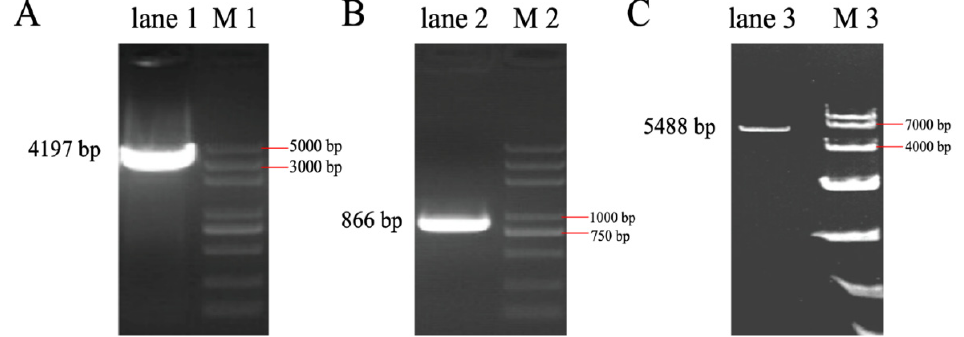
Figure 3. The full-length sequence of LincRNA-ROFM was obtained by RACE technology. ( A ) The result of 5 ′ -RACE in lane 1. ( B ) The result of 3 ′ -RACE in lane 2. ( C ) Agarose gel test to verify the full length of LincRNA-ROFM in lane 3. Note: M1: marker is DL 5000; M2: marker is DL 5000; M3: marker is DL 10,000.